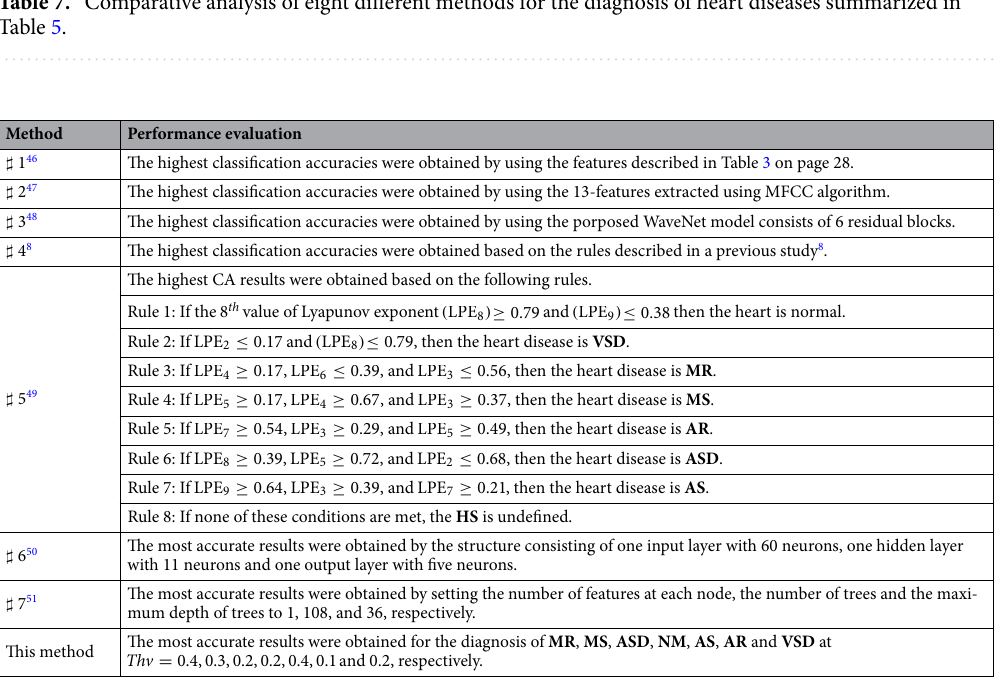
Table 8. The highest accuracies corresponding to the parameters set in every state-of-the-art